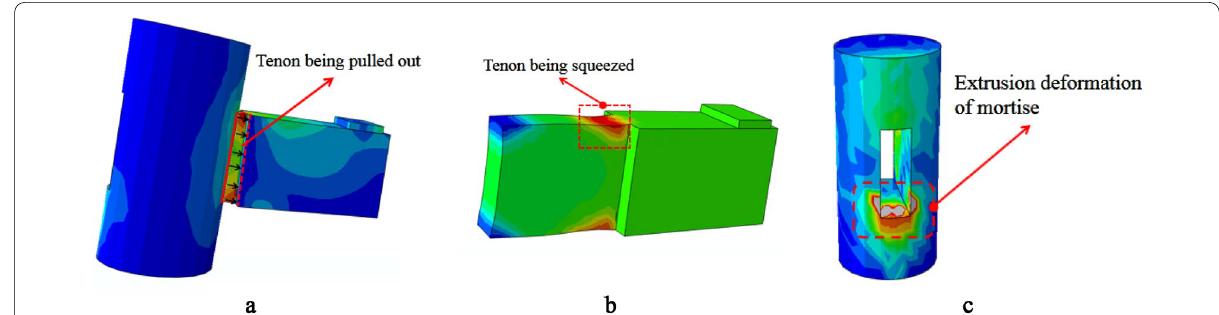
Fig. 23 Failure patterns of VC-FEM of straight tenon